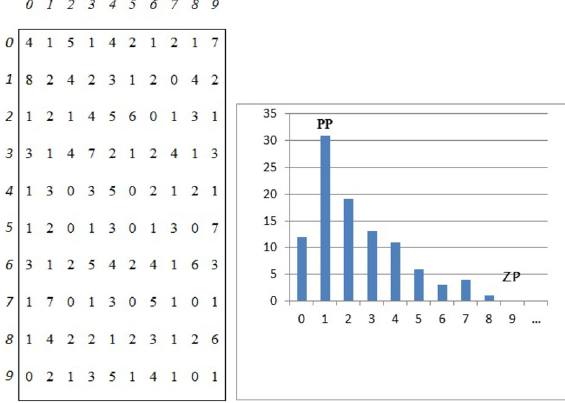
Fig. 1 Original histogram of G ( x , y